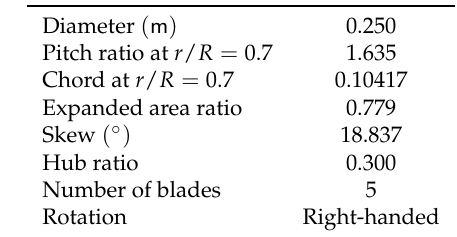
Figure 2. Photographs of the Potsdam propeller test case (PPTC) propeller [51]. Table 1. Main geometric parameters of the PPTC